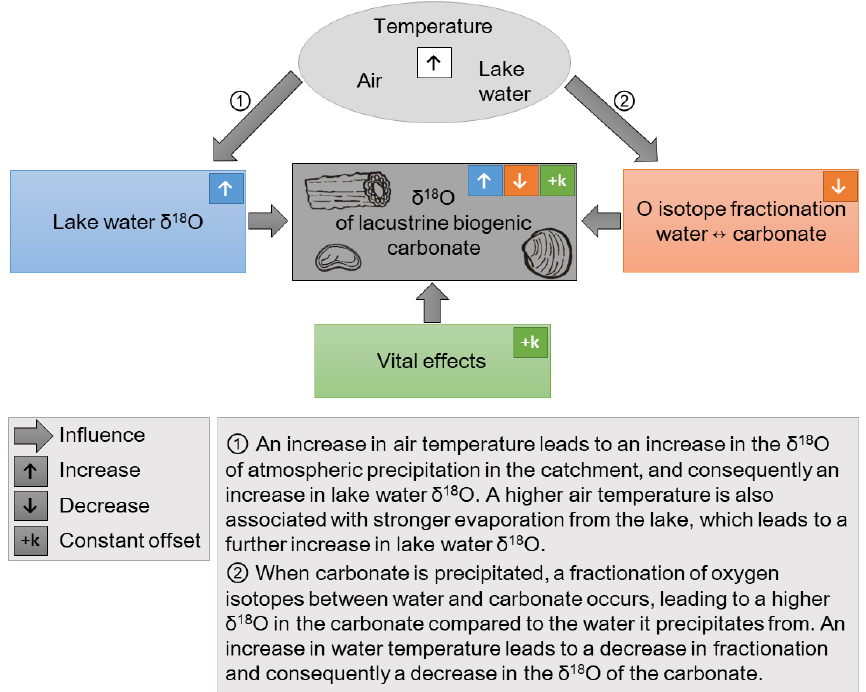
Figure 1. A simplified schematic representation of the influences on the oxygen isotopic composition ( δ 18 O) of lacustrine biogenic car- bonates. The isotopic composition of precipitation is correlated with air temperature in middle and high latitudes (Rozanski et al., 1992). A higher air temperature leads to a higher lake water δ 18 O, as indicated in 1 (cid:13) , which is reflected in the δ 18 O of the carbonates. There are addi- tional influences on lake water δ 18 O, such as catchment and lake hydrology, relative humidity, and the seasonal distribution of atmospheric precipitation, which are not represented in the figure. The fractionation of oxygen isotopes between water and carbonate is also temperature- dependent, as indicated in 2 (cid:13) . Note the opposite directions of the temperature influence on 1 (cid:13) lake water δ 18 O and on 2 (cid:13) fractionation. As a consequence, temperature has two opposing effects on the δ 18 O of carbonates. Lastly, “vital effects” which are dependent on the specific physiology of each species, lead to a constant offset between the δ 18 O of the biogenic carbonate and inorganic carbonate which would precipitate in isotopic equilibrium with the